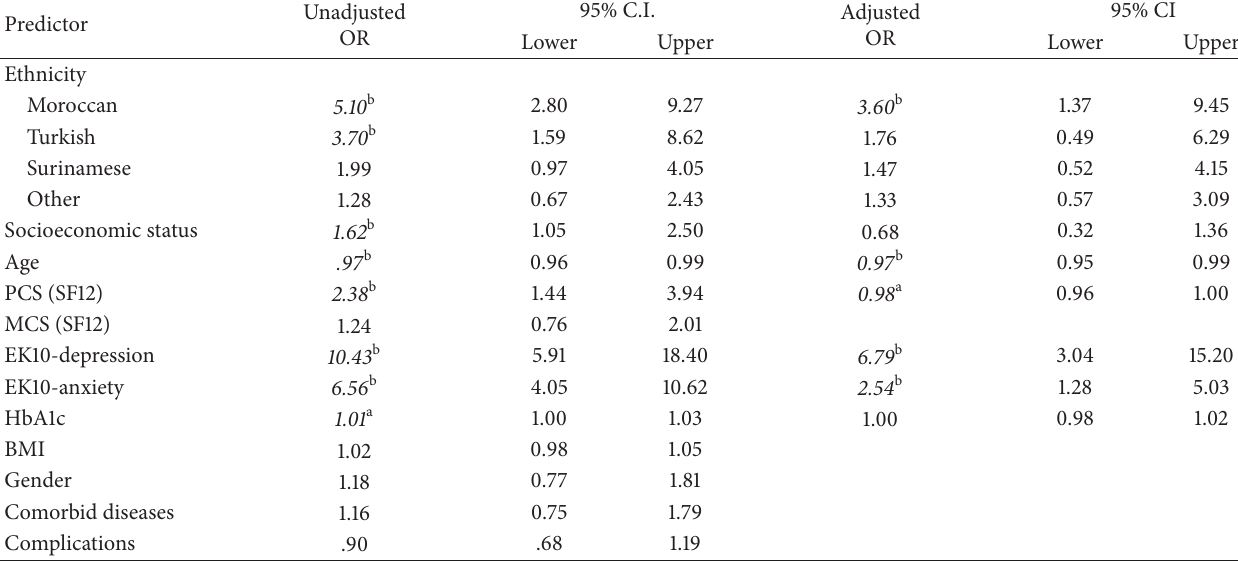
Table 4: Unadjusted and adjusted logistic regression analyses of variables associated with diabetes-distress (PAID5). Unadjusted Predictor OR Ethnicity